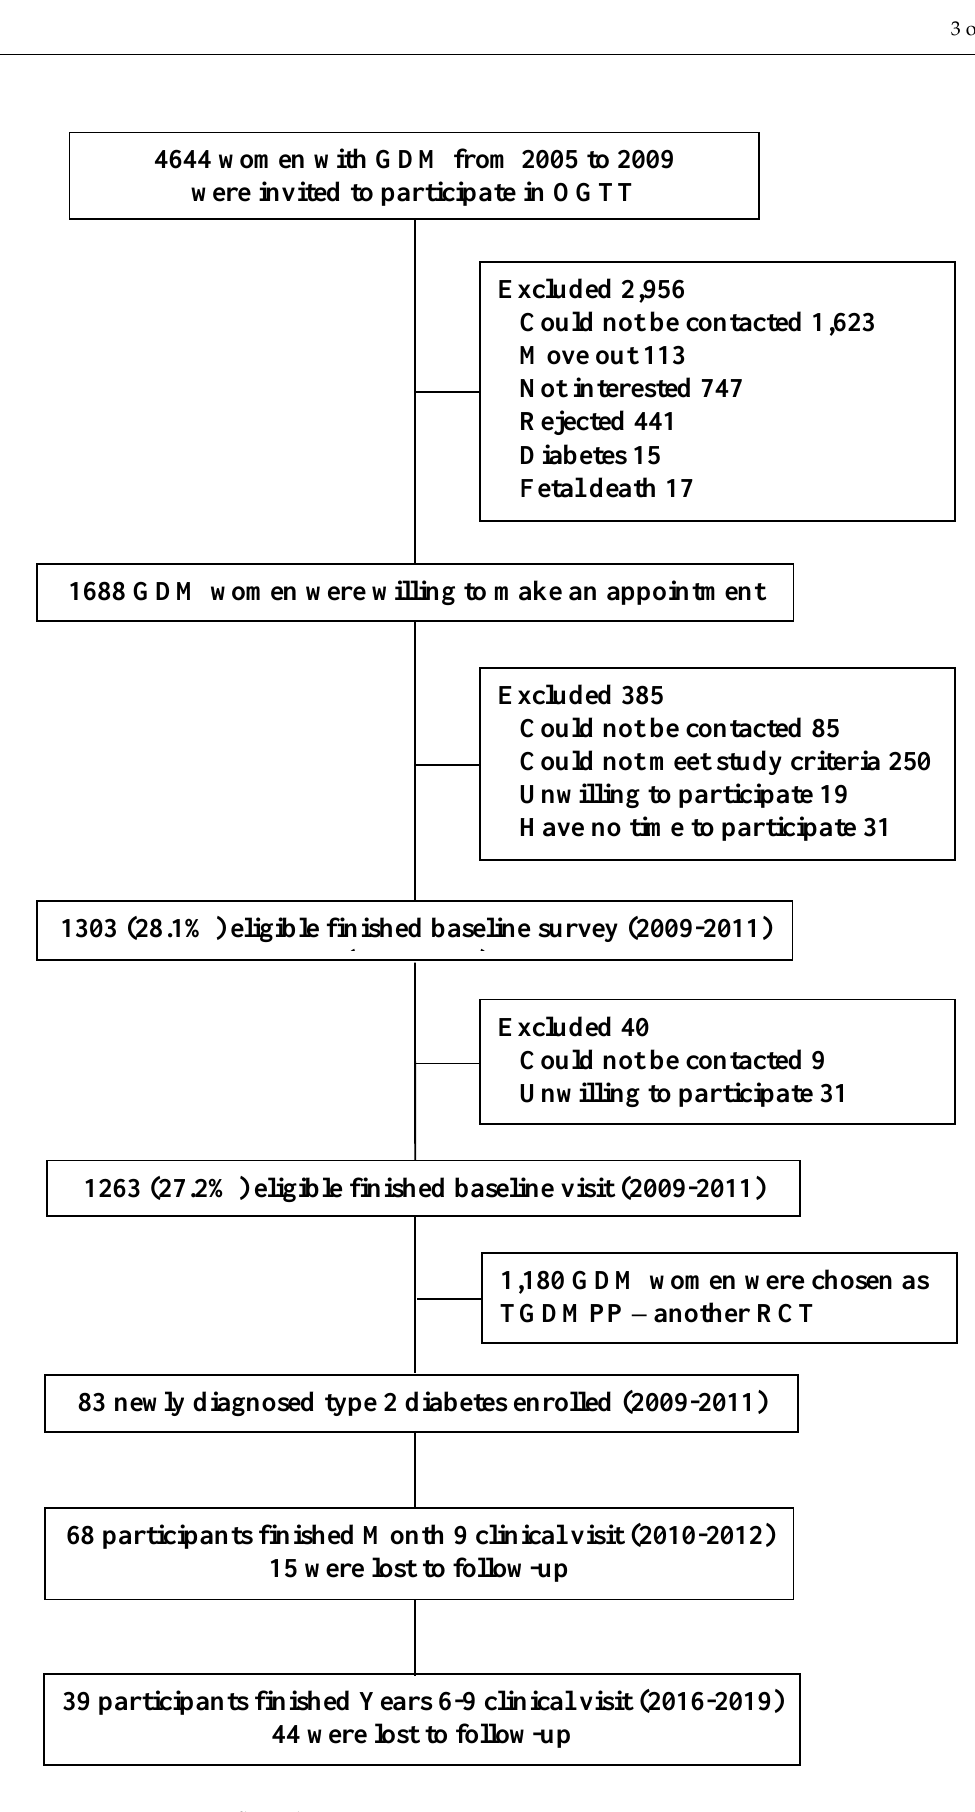
Figure 1. Participant flow